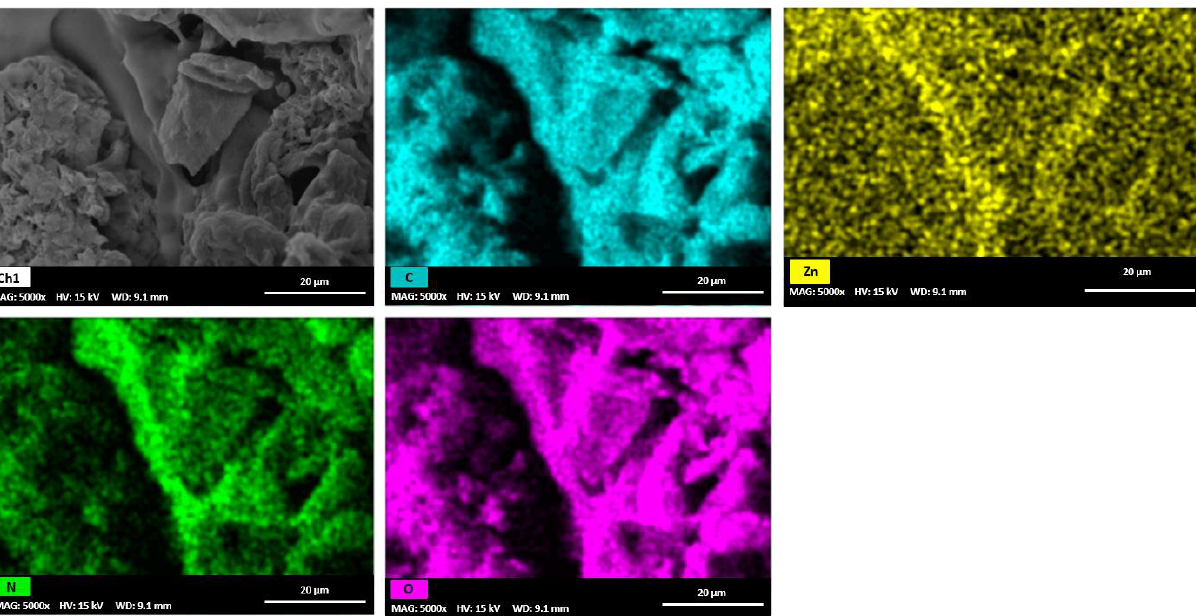
Figure 2. Distribution of elements on CNS-Cu observed with EDS analysis.